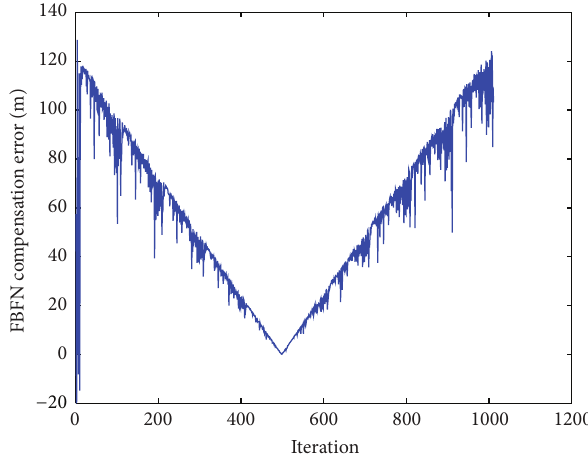
Figure 20: Error compensation value of FBFN